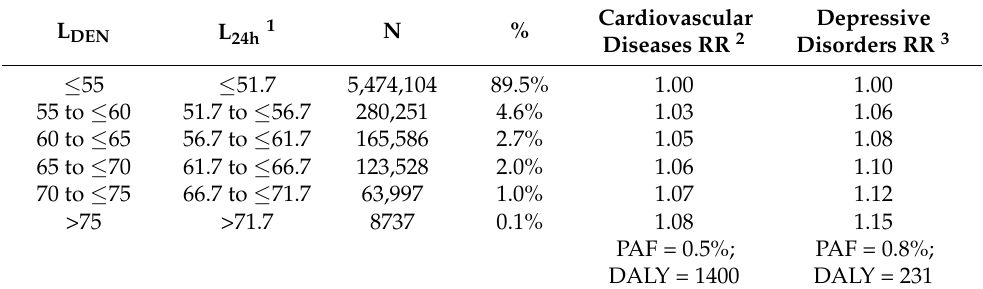
24h values of 40 dB(A) using the dose-response relationship for cardiovascular diseases: 1.024 per 10 dB (A) [41]; 3 risks calculated for the median of the categories starting from L 24h values of 40 dB(A) using the dose-response relationship for depressive disorders: 1.041 per 10 dB(A) [32].